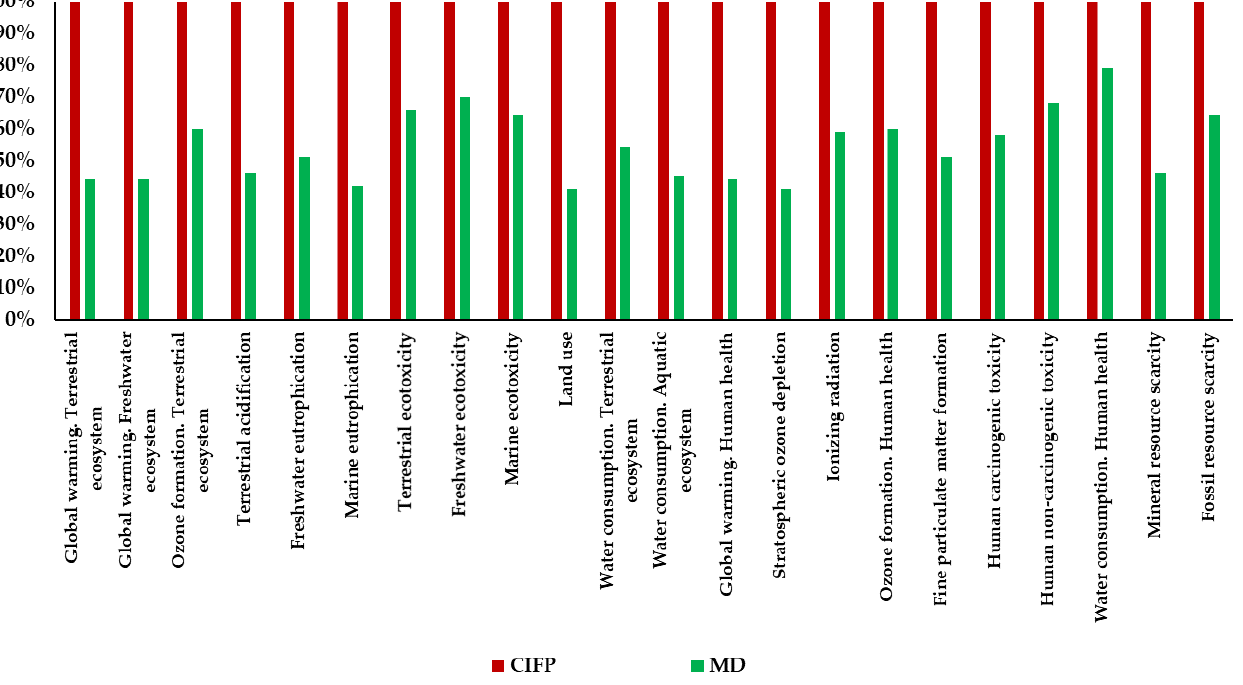
Figure 3. Different impacts of Italian consumption and the Mediterranean diet (MD: Mediterranean diet; CIFP: Current Italian food patterns).